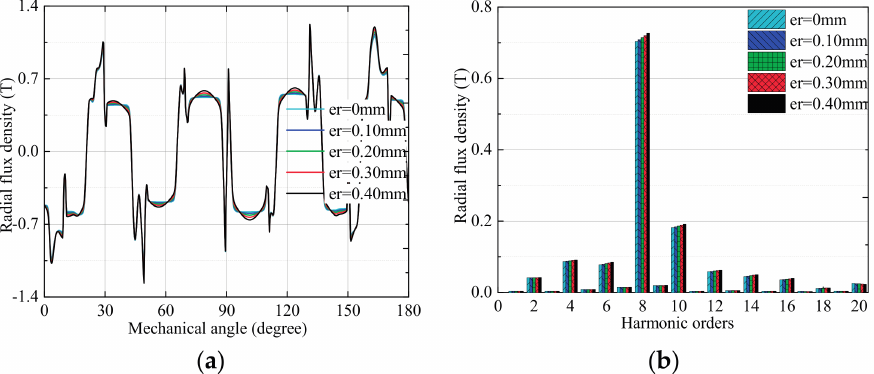
Figure 13. Analysis of the radial component of magnetic flux density in the IPMSM with rotor deformation at high-speed load condition. ( a ) Distribution curves; ( b ) Harmonic